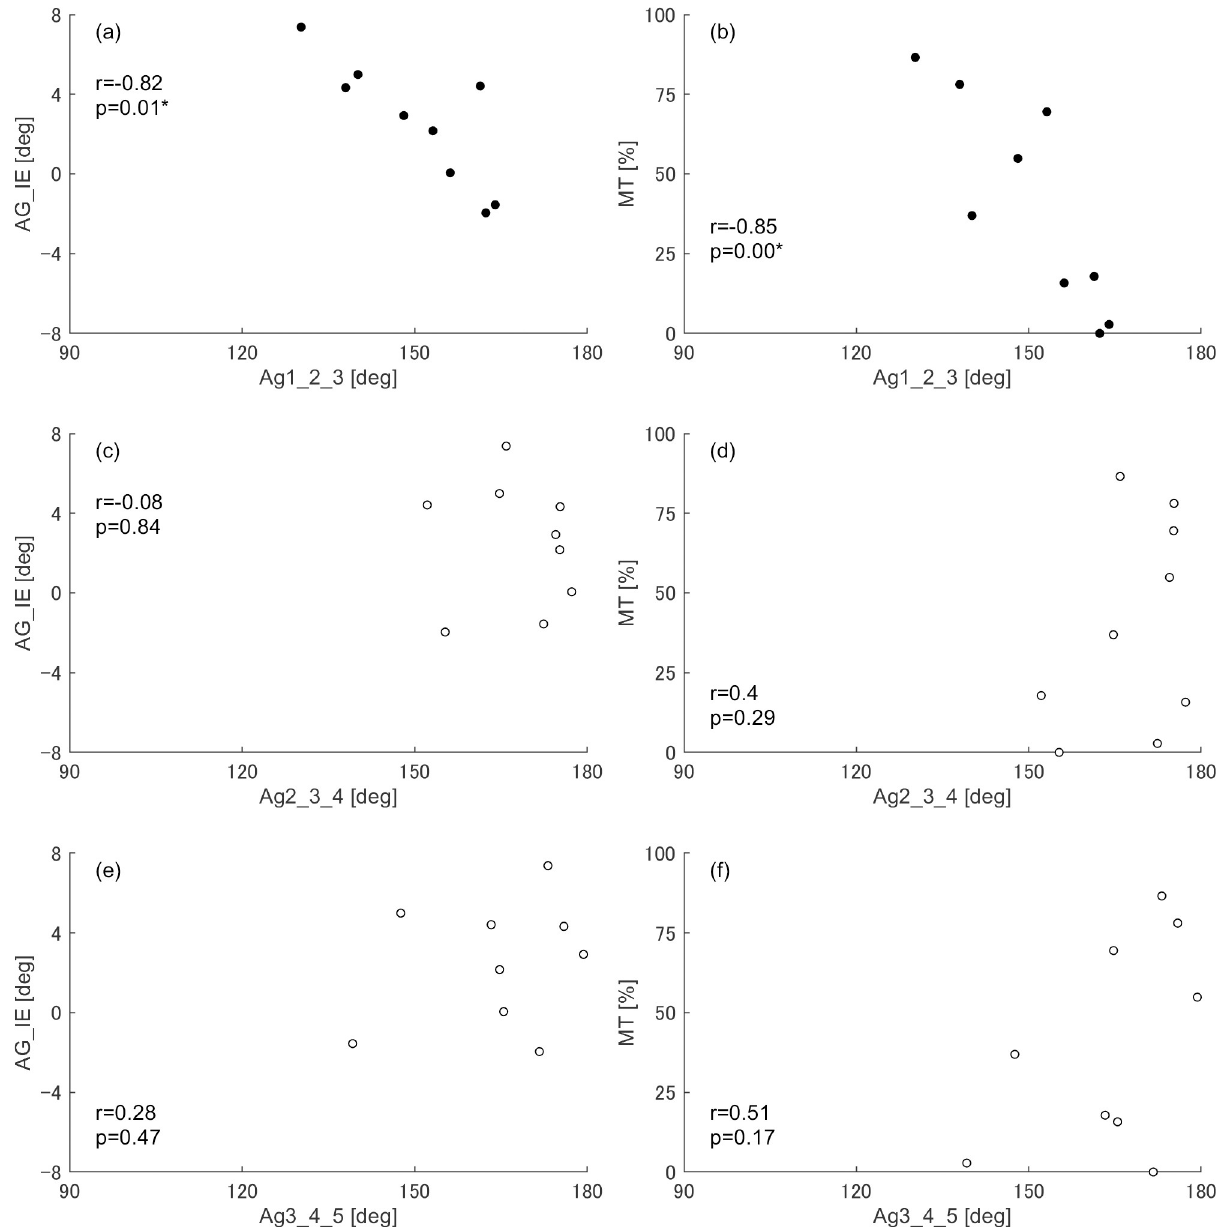
Fig 3. Correlation between angles representing metatarsal alignment and relevant variables when standing on the non–dominant leg. AG_IE and MT indicate the mean foot inversion ( − )/eversion (+) angle and the % duration when the centre of pressure positions was located medial to the second metatarsal head, respectively, against the total duration of the balancing phase. Graphs with black circle plots indicate significant correlations with the angle representing metatarsal alignment and variables after consideringeffects of the multiple testing. (a) the foot inverts as the angle 1-2-3 becomes significantly wider; (b)% duration to load medially decreases as the angle 1-2-3 becomes significantly wider; (c) the foot inversion/eversion angle does not correlate with the angle 2-3-4; (d) % duration to load medially does not correlate with the angle 2-3-4; (e) the foot inversion/eversion angle does not correlate with the angle 3-4-5; (f) % duration to load medially does not correlate with the angle